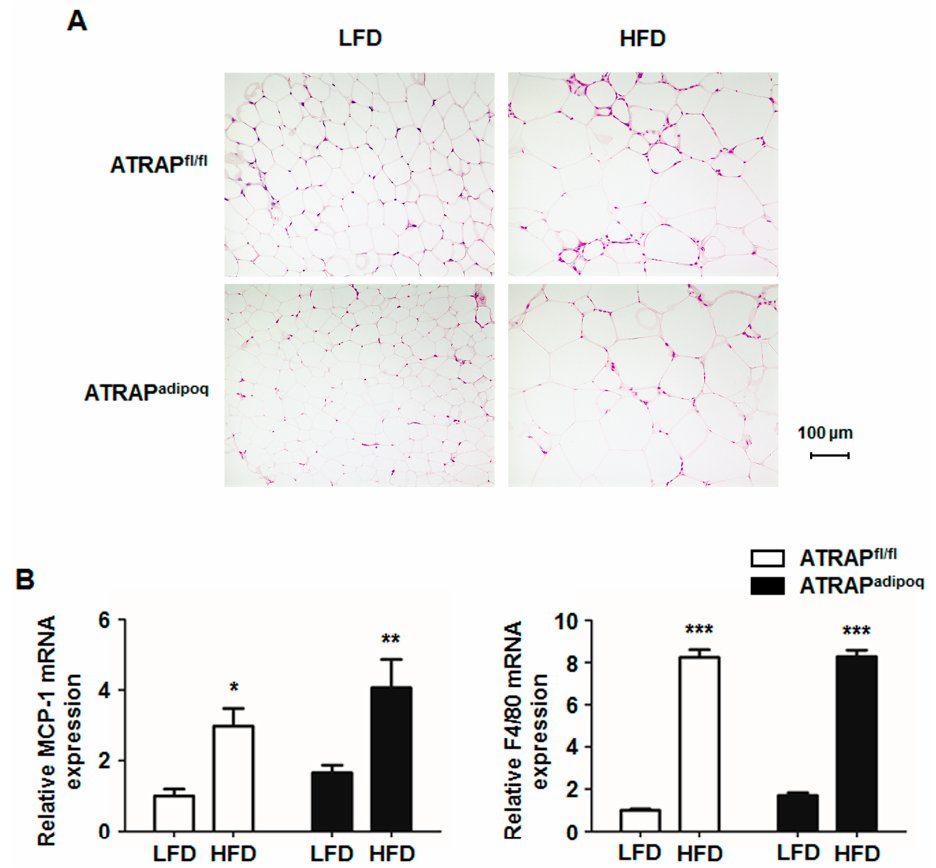
Figure 5. Adipocyte morphology and inflammation of WAT. ( A ) Representative images of adipocyte cells in WAT of ATRAP fl/fl and ATRAP adipoq mice fed an LFD and HFD. ( B ) Relative monocyte chemotactic protein-1 (MCP-1) and F4/80 mRNA expression in WAT of ATRAP fl/fl and ATRAP adipoq mice fed an LFD and HFD ( n = 5–6). Values are the means ± SEM. * p < 0.05, ** p < 0.01, *** p < 0.001 vs. LFD within the same group. Data were analyzed by two-way ANOVA. LFD: Low-fat diet; HFD: High-fat diet.